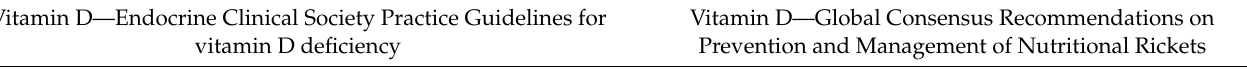
Table 2. Vitamin D deficiency, insufficiency, and optimal level cut-offs used to assess vitamin D status. Vitamin D (ng/mL), Total Group N =